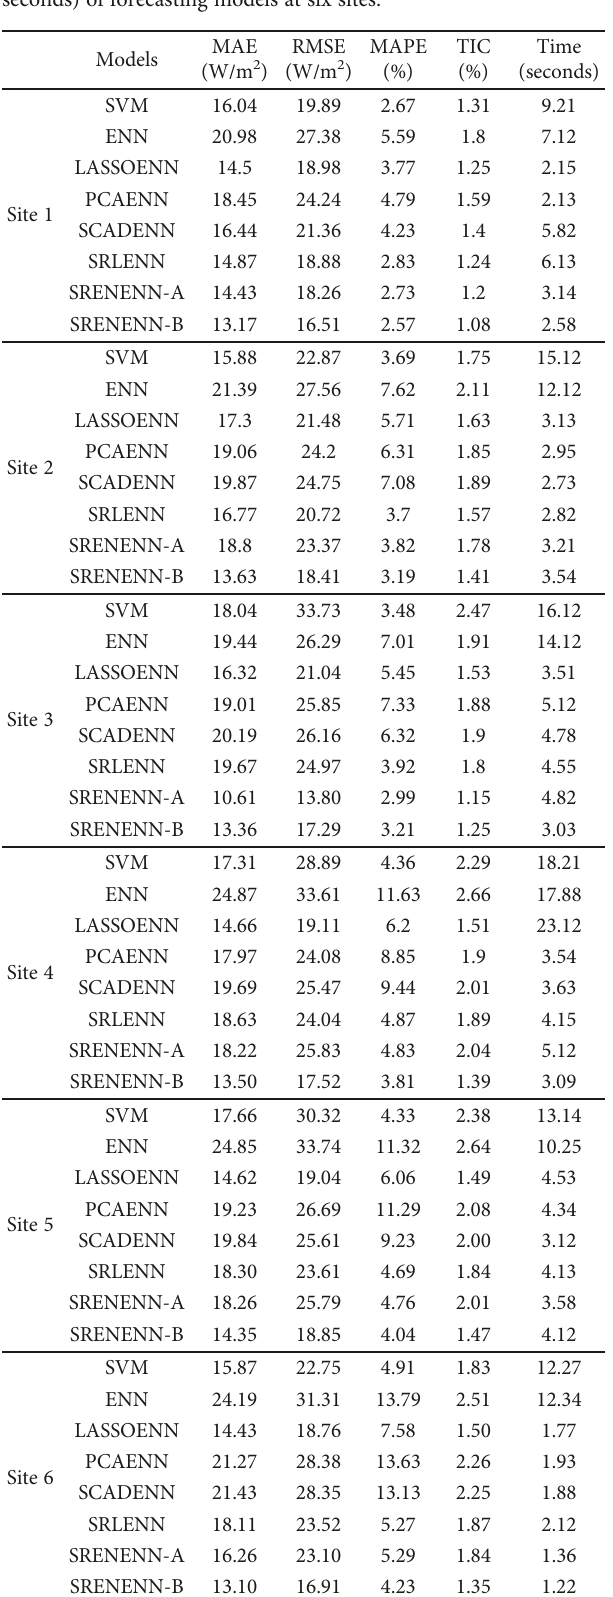
Table 3: Mean forecasting errors and computation time (in seconds) of forecasting models at six sites.